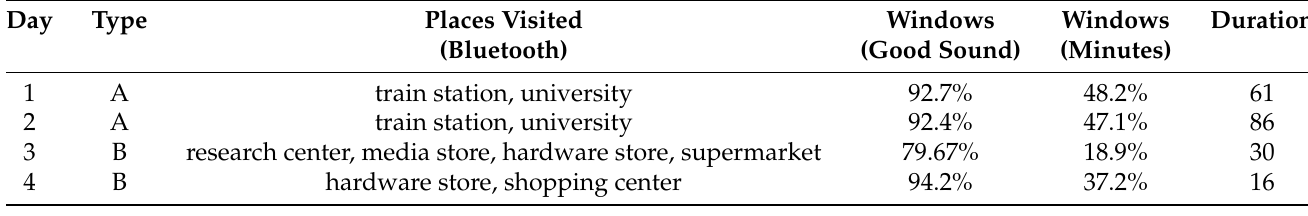
Table 1. Description of the days when we recorded data. Time in each day is the experiment duration, but instances are generated between phones being held by different people, so the number of 5 s windows exceeds the experiment duration given that experiments included five subjects, each carrying two phones (1 iOS and 1 Android). Percentages of availability are calculated using those windows between users. The days are divided into two types (A and B) based on the locations visited.